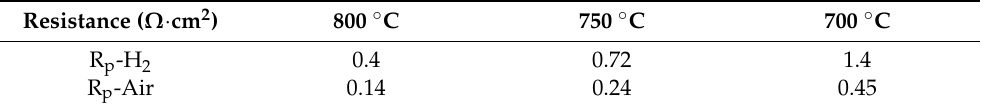
Figure 5. Polarization resistance of SFMO nanofiber electrode without ohmic resistance measured at 700, 750, and 800 ◦ C in humidified air ( a ) and H 2 ( b ). Table 1. The area-specific resistances for SFMO symmetrical